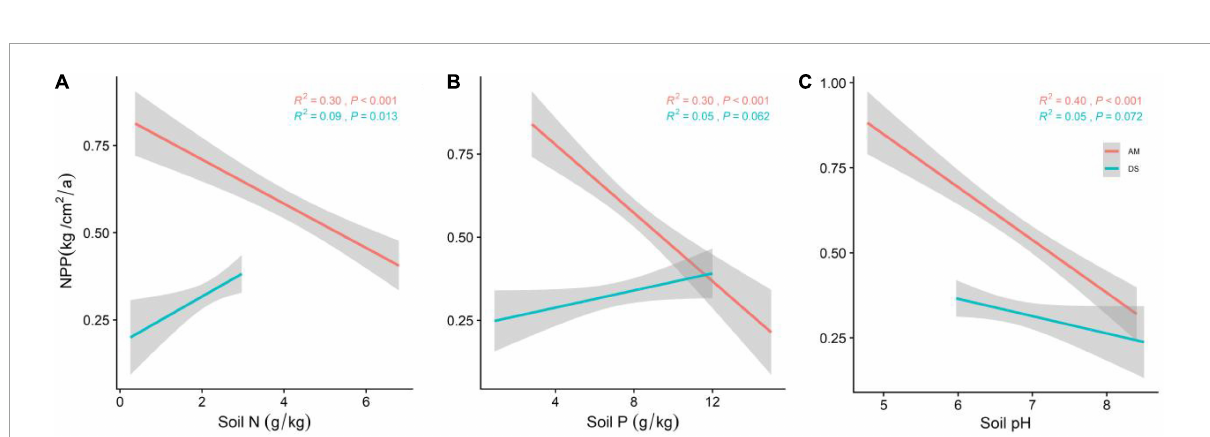
FIGURE4 General linear regression analysis between soil nutrient factors and the NPP (soil N, soil P and soil PH) of AM and DS. (A) General linear relationship between soil N and the NPP of AM and DS; (B) general linear relationship between soil P and the NPP of AM and DS; (C) general linear relationship between soil pH and the NPP of AM and DS. The shaded area shows a 95% confidence interval. The red line represents the NPP of AM and the green line represents the NPP of DS; R 2 represents the model fit and P represents the